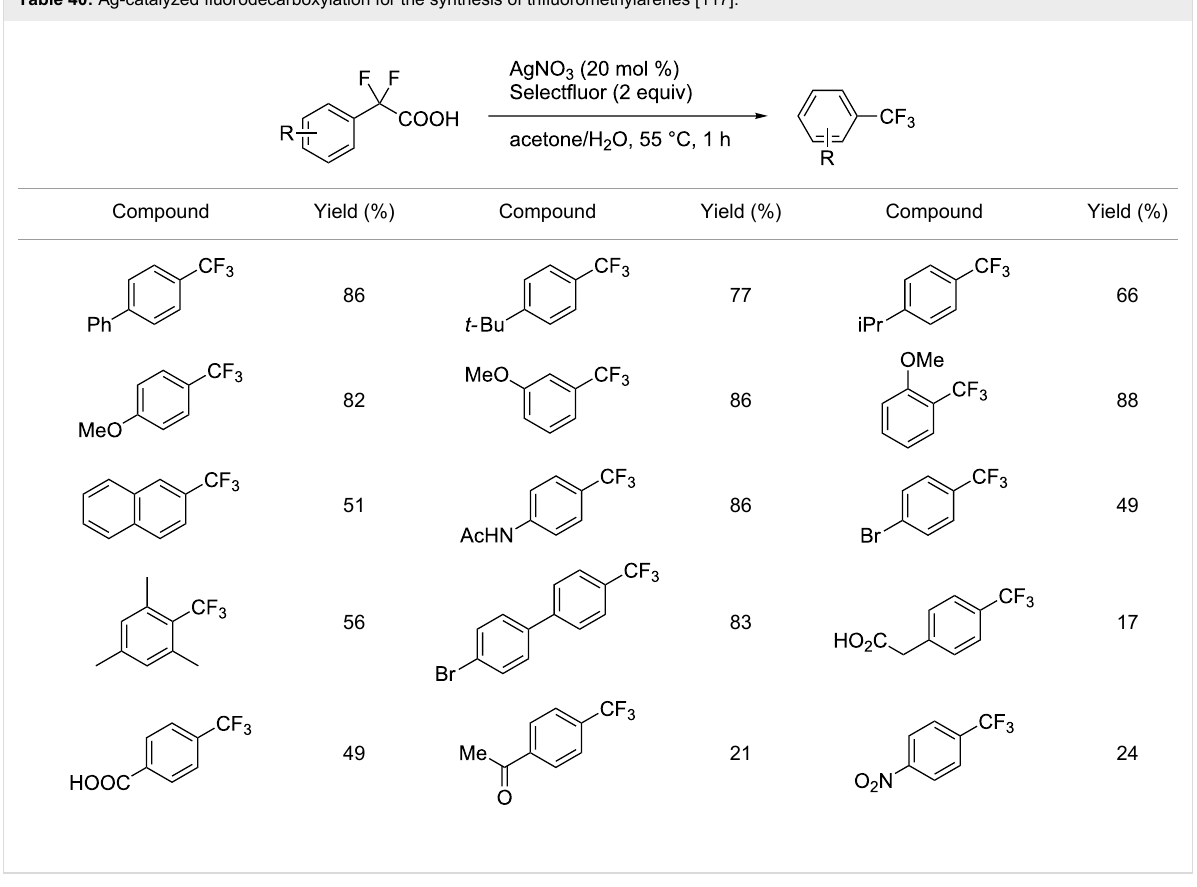
Table 40: Ag-catalyzed fluorodecarboxylation for the synthesis of trifluoromethylarenes